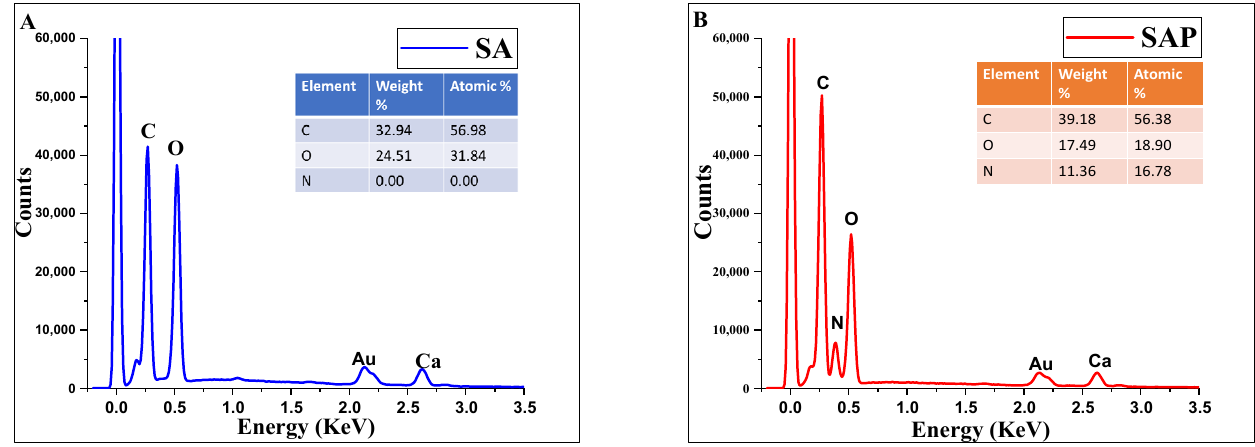
Figure 6. Surface Energy Dispersive X-ray (EDX) spectra of Sodium alginate and sodium alginate covered with PEI ( A ) EDX spectrum of SA and ( B ) EDX spectrum of SAP.